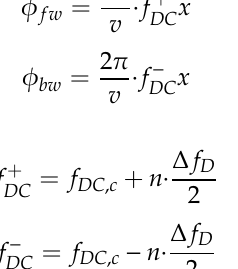
observed in the master and slave acquisitions by the SAR sensor with slightly different viewing in the master and slave acquisitions by the SAR sensor with slightly di ff erent viewing geometries.